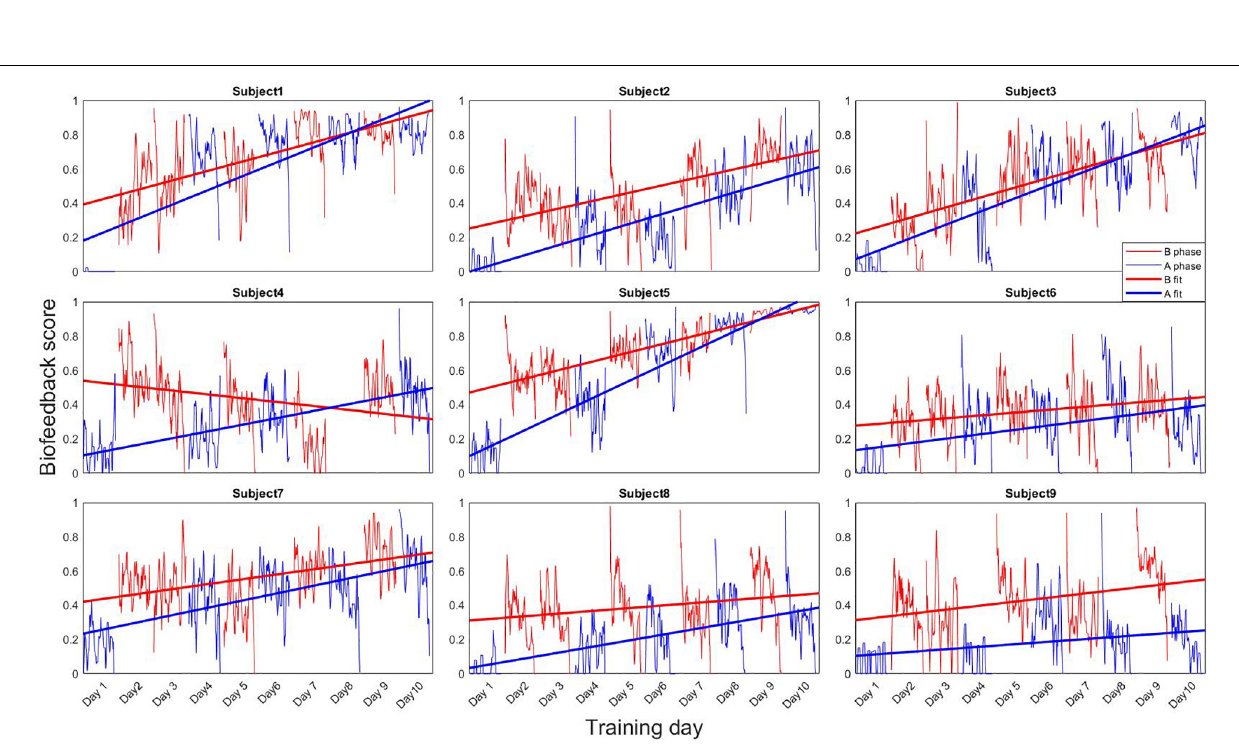
FIGURE 5 | Evolution of the breathing biofeedback score across the entire training period. Each datapoint represents the average biofeedback value for a 15 s epoch. Scores range from 0 (no adherence to the rewarded breathing pace) to 1 (perfect adherence to the rewarded breathing pace). B phase, breathing score for B phase sessions (Session 2, 3, 5, 7 and 9); A phase, breathing score for A phase sessions (Session 1, 4, 6, 8 and 10); B fit, fitted line for the B phase sessions; A fit, fitted line for the A phase